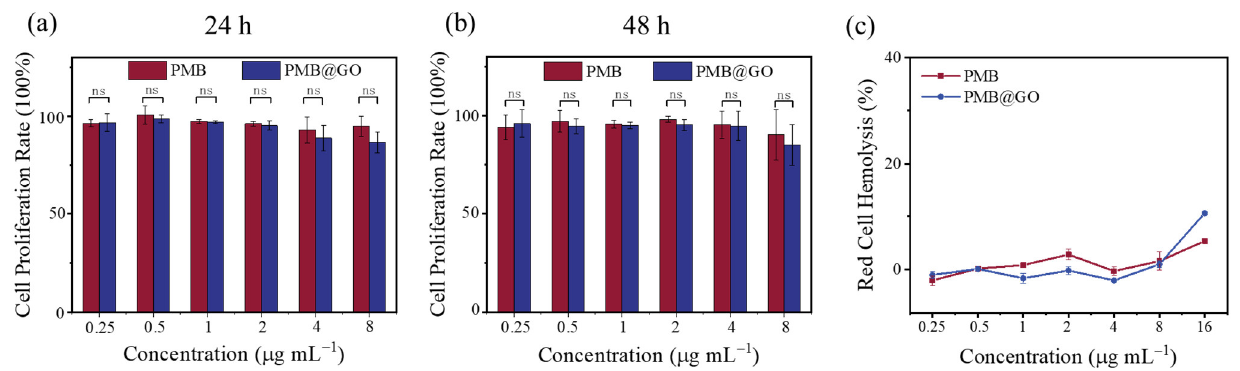
Figure 3. Toxicity tests of free PMB and PMB@GO nanocomposites. ( a , b ) Standard MTT cell viability assay of mouse gastric cancer (MGC)-803 cells cultured with free PMB or PMB@GO for 24 or 48 h. The concentrations of the agents varied between 0.25 and 8.0 μg mL −1 . p -values were calculated by ANOVA (ns means p > 0.05). ( c ) Hemolytic activity of the agents. Red blood cells in PBS and ultrapure water were used as negative and positive controls, respectively, for determination of the hemolysis percentage values. The data show the normalized mean and standard error of at least three independent experiments.